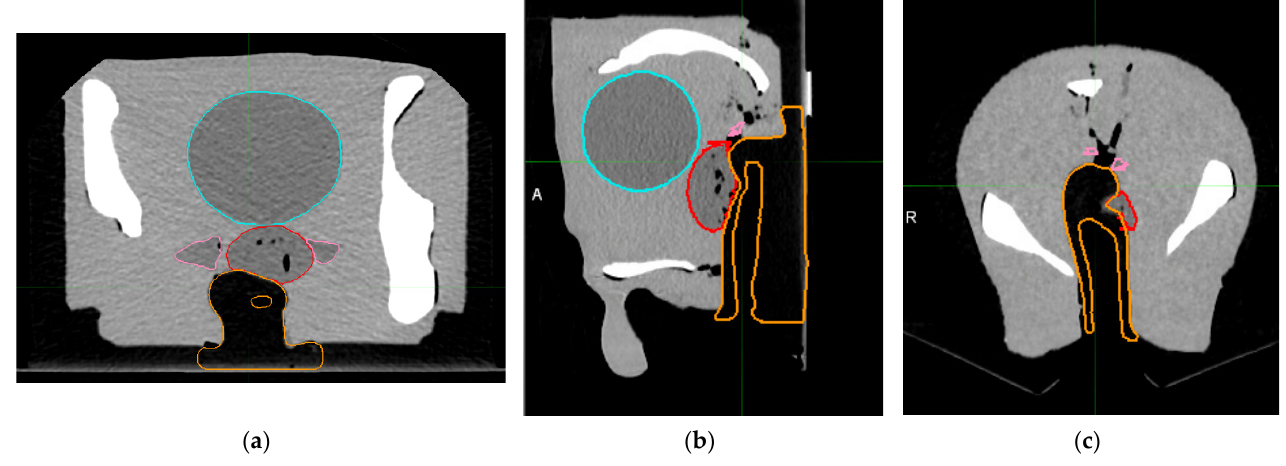
Figure 2. The CT scan of the CIRS phantom simulating the pelvis region with the contouring of the prostate (red), seminal vescicles (pink), bladder (light blue), and rectum (orange). ( a ) Transverse plan; ( b ) sagittal plan; ( c ) coronal plan.